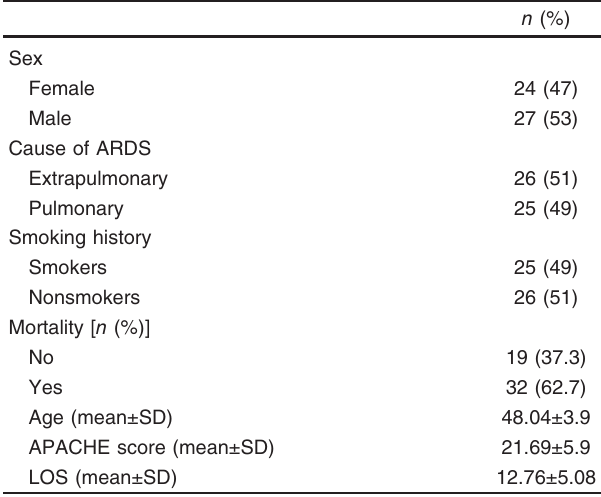
Table 1 Descriptive characteristics of the cases included in the